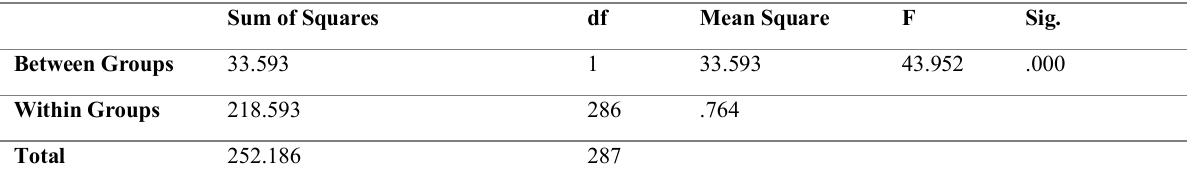
Table 2: ANOVA of Leadership Development with Respect to Learning Goal Orientation